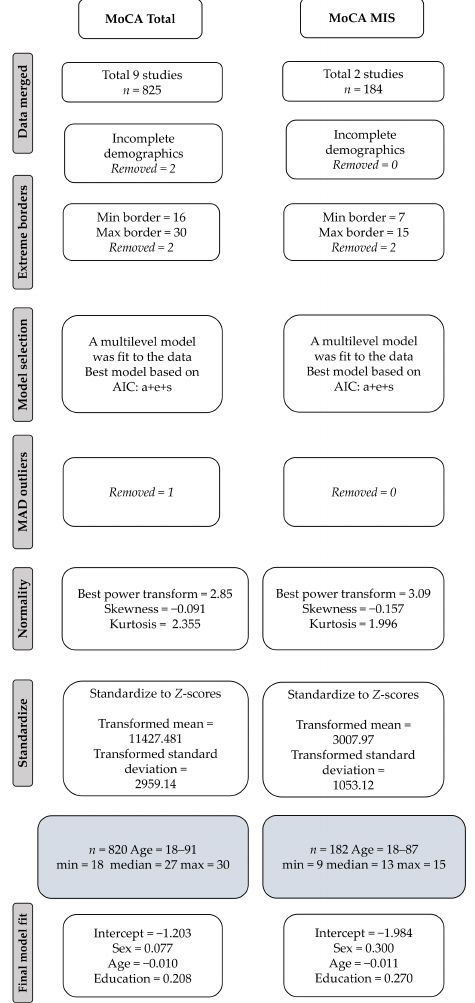
Figure 1. Flowchart showing the included studies and their data